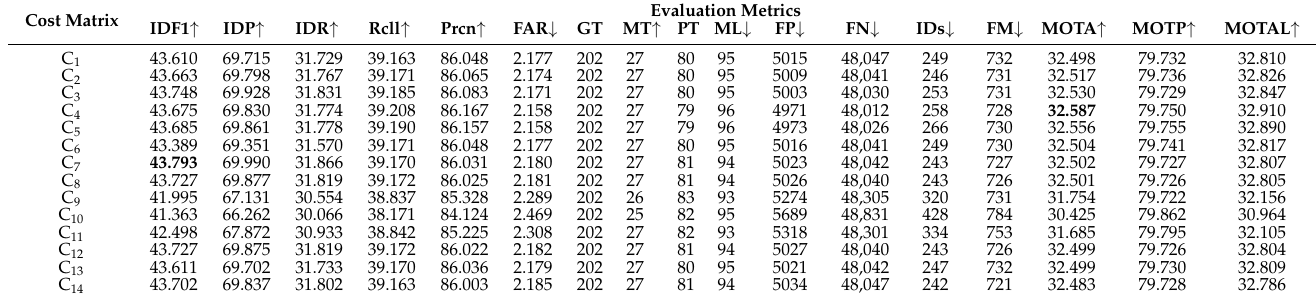
Table 2. Evaluation of Deep-SORT using a combination of our proposed data association cost matrices on the MOT17